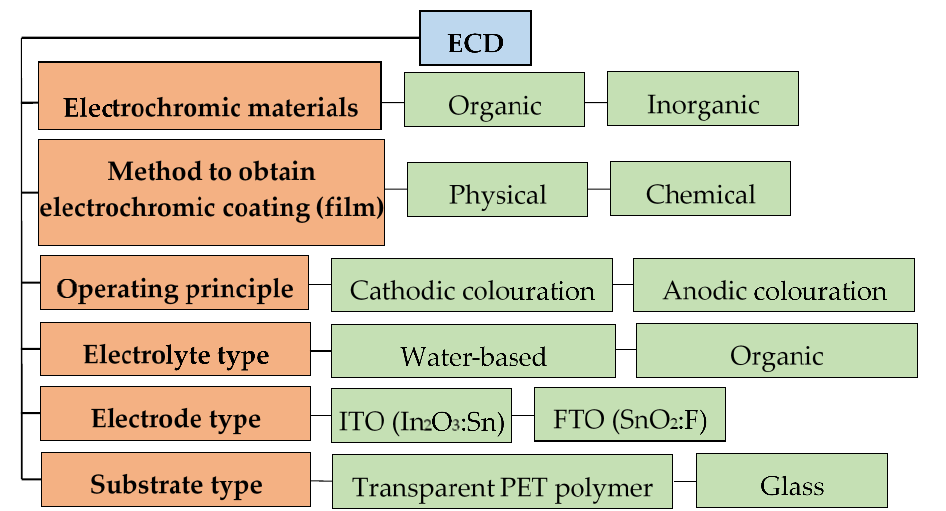
Figure 21. ECD classification.